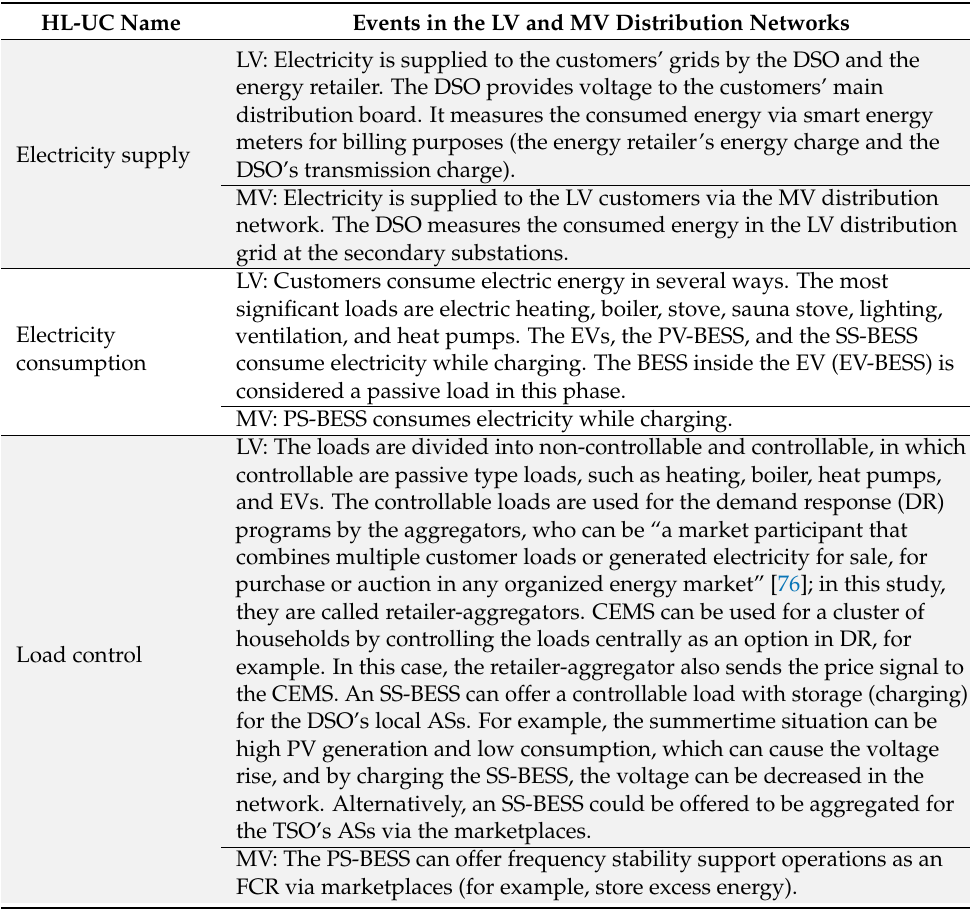
Table 3. Energy management high-level use cases in the self-sufficient